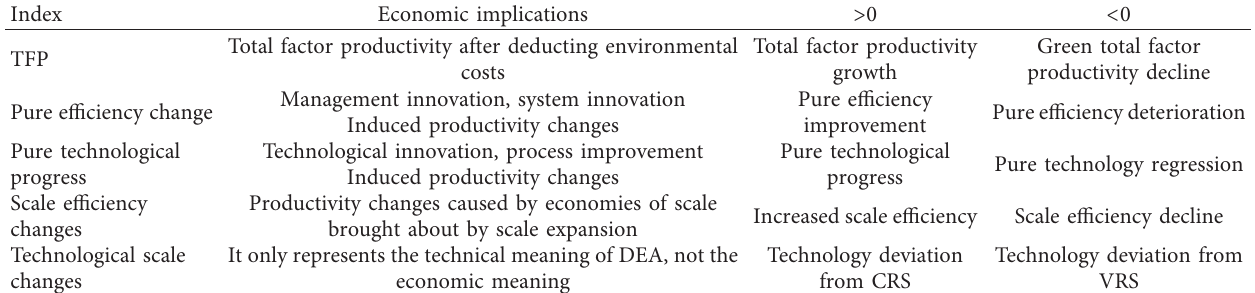
Table 9: Economic implications of TFP and its breakdown indicators.